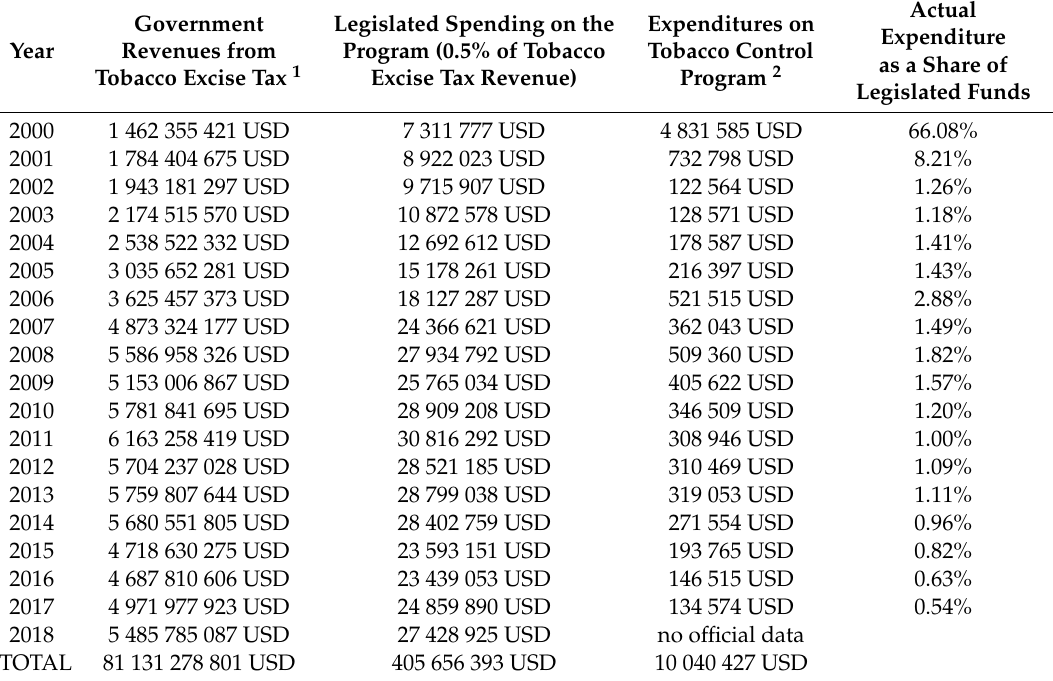
Table 3. Legislated versus actual spending on the Tobacco control Program in